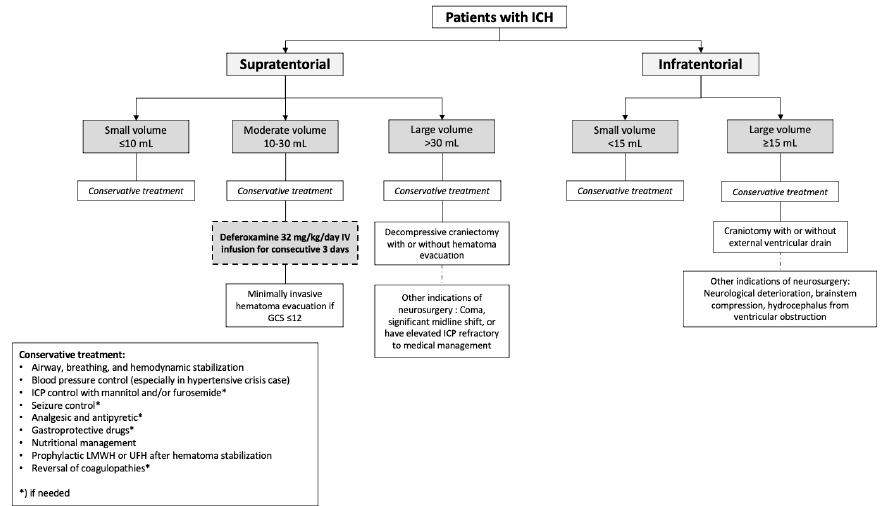
Figure 3. Hypothetical algorithm of ICH treatment with attribution of deferoxamine (dashed box) considering hematoma location and volume. GCS, Glasgow coma scale; ICP, intracranial pressure; LMWH, low-molecular-weight heparin; UFH, unfractionated